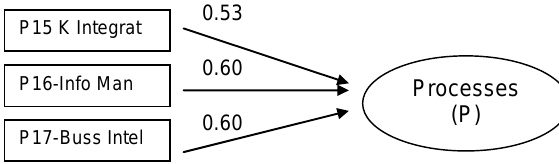
Figure 5: Relative weights of Processes indicators Technology The independent variables correlation for Technology (T) is shown in Table